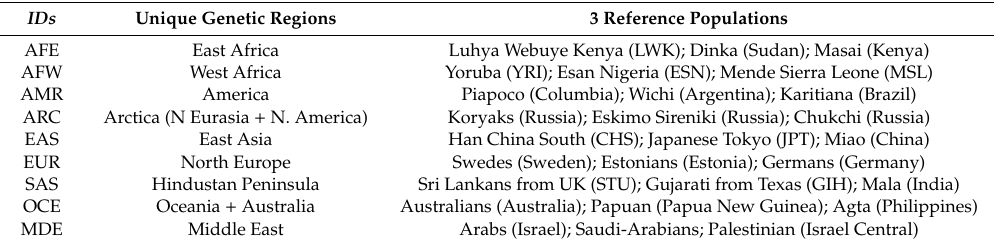
Table 3. Nine Distinct Human Genetics Regions (DHGR), each characterized by three reference populations that share the least number of IBD fragments with the rest of the